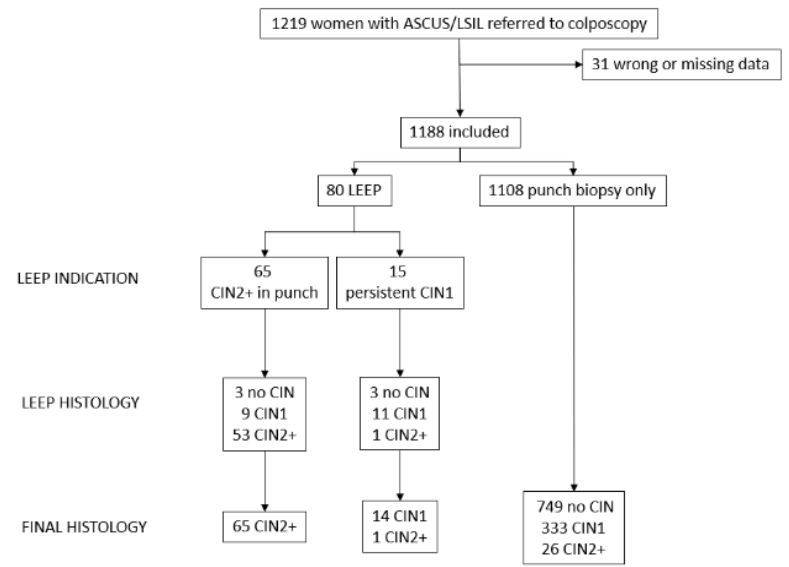
Figure 1. Flow chart of included and excluded patients and their anatomopathological results. Table 1. Main characteristics of the cohorts.